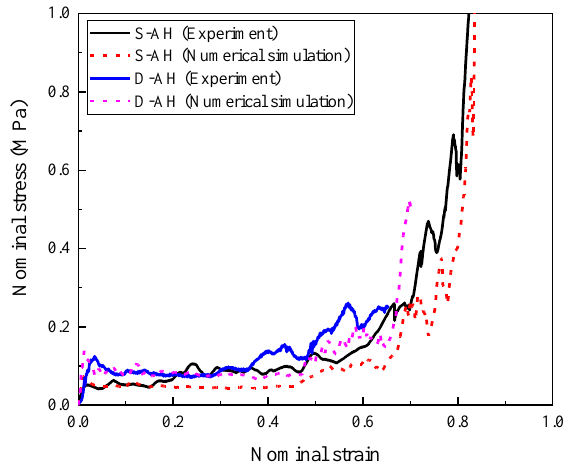
Figure 7. The measured and simulated stress–strain relationships of hollow auxetic honeycomb in quasi-static and dynamic compression tests.